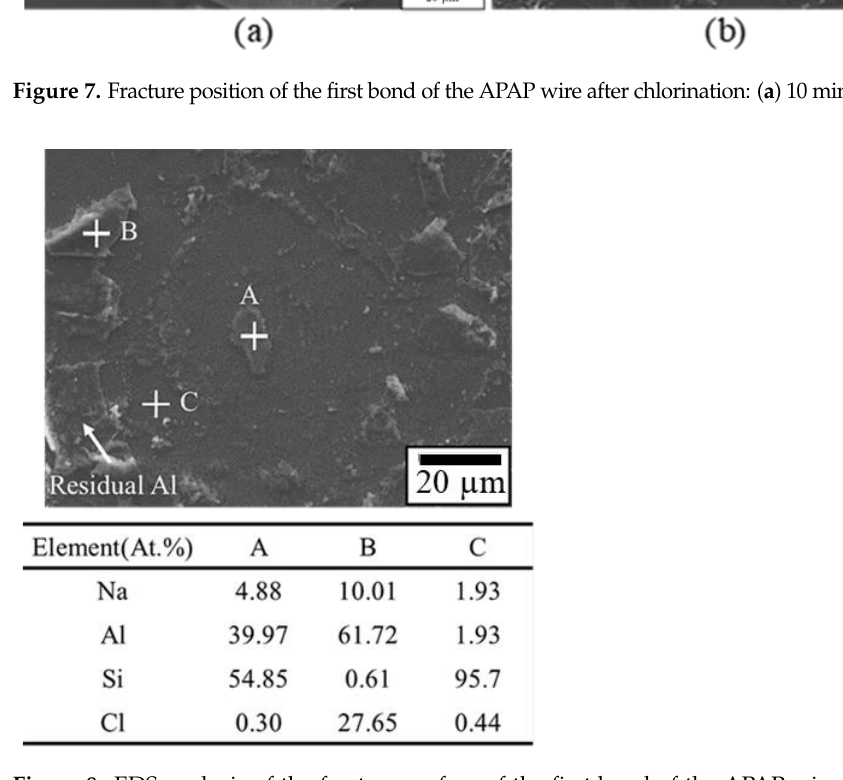
Figure 8. EDS analysis of the fracture surface of the first bond of the APAP wire after 30 min of chlorination. (A, B: residual aluminum film; C: silicon substrate)